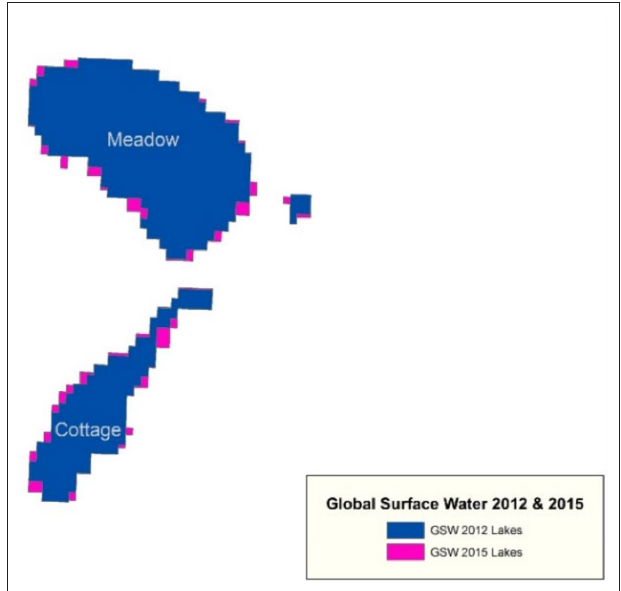
FIGURE 3 | The digital map for two lakes showing the presence of water in the cells; the magenta cells are locations where water was present in 2015 but not in